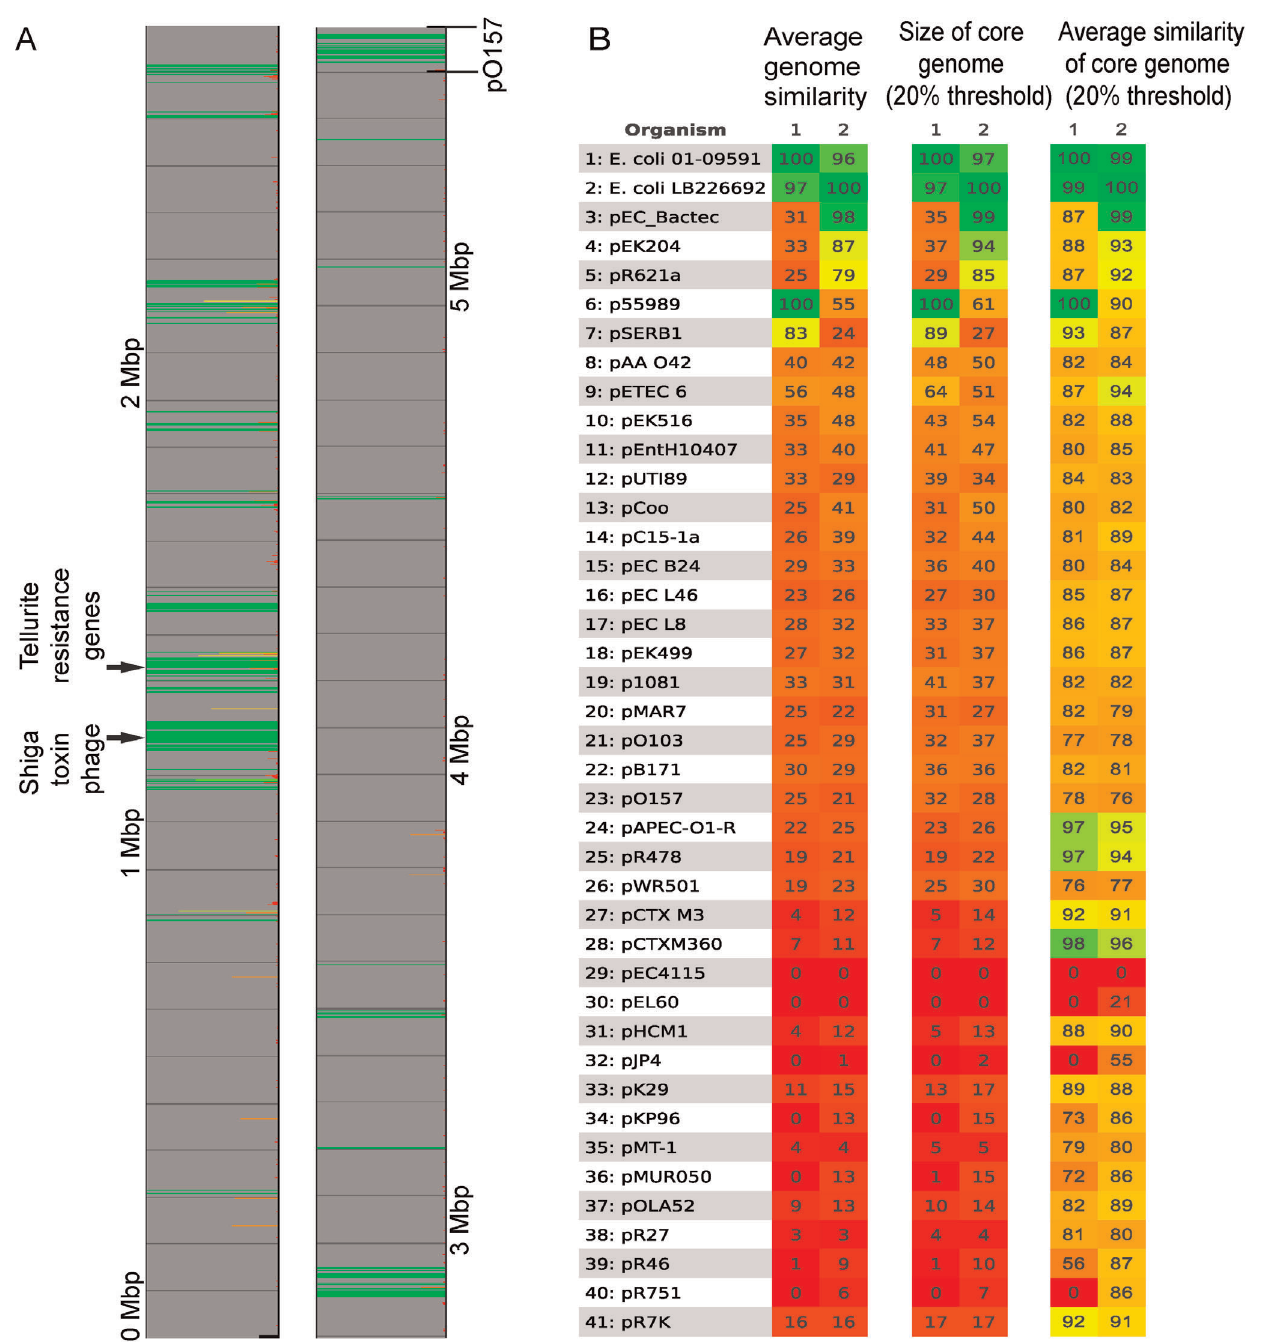
Figure 6. Signature analysis of the E.coli O104:H4 strain from the food poisoning outbreak in 2011. A. A signature representing the genetic material that the outbreak strain LB226692 (accession AFOB02000000) has in common with previous severe food-poisoning outbreak strains (Sakai Japan 1996 (accession NC_002695), Michigan and Oregon 1982 (accession NC_002655), the spinach outbreak in western USA 2006 (accession NC_013008) and the lettuce outbreak in eastern USA 2006 (accession NZ_ABKY00000000)) but not in common with a background strain representing another E. coli O104 strain 55989 (accession NC_011748). B. Plasmid profiling using Gegenees. Two O:104 isolates, one from the 2011 outbreak (LB226692) and the other a HUS-associated O104 strain from 2001 (accession AFPS01000000), were compared to a set of plasmids with a fragmented alignment 200/100 using BLASTN.